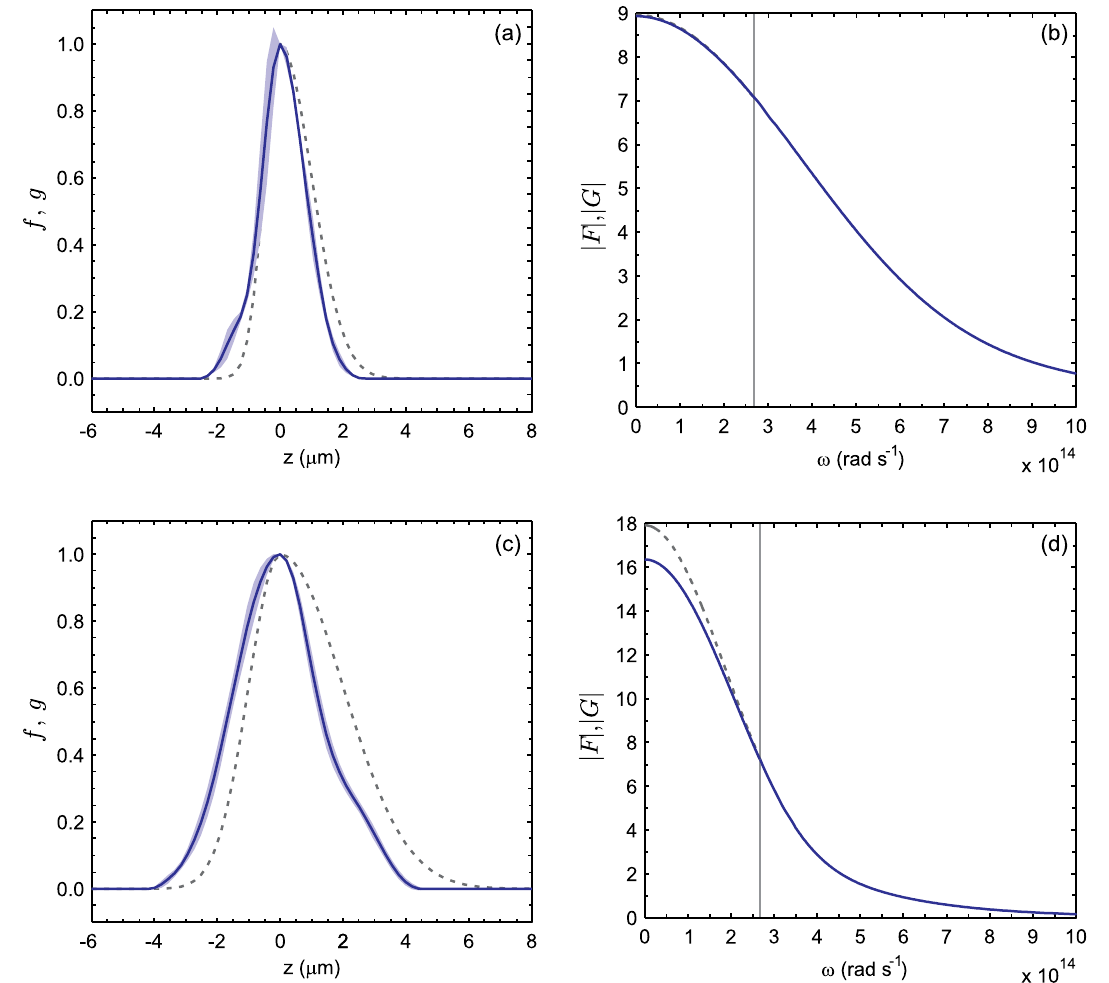
FIG. 3. Reconstruction of sample asymmetric bunch profiles. Initial profiles are shown as dashed gray lines in (a) and (c). The mean of the reconstructed profiles—from ten reconstructions with randomized initial data—are shown as blue lines. The light blue shading represents three- (cid:7) deviation from the mean. Profile (a) is a combination of half Gaussians of rms lengths 0 : 5 (cid:6) m (to the left of z ¼ 0 ) and 1 (cid:6) m (to the right); for profile (c) the lengths are correspondingly 1 (cid:6) m and 2 (cid:6) m . The spectral amplitudes corresponding to the original and reconstructed profiles are shown in (b) and (d). Spectral data is withheld from the phase-retrieval algorithm for ! < 2 : 7 (cid:7) 10 14 rad s (cid:2) 1 , which is the only region where discrepancies between the original and reconstructed spectra